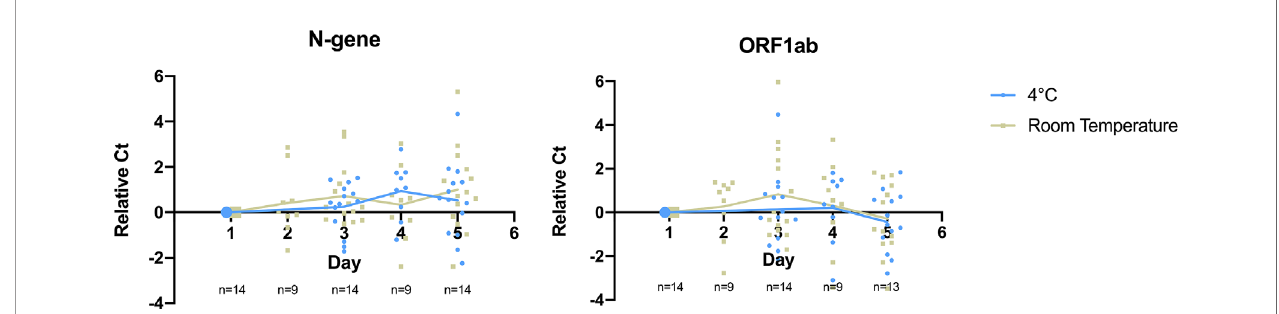
FIGURE 3 | Detection of SARS-CoV-2 target genes N-gene and ORF1ab remained stable for 5 days at cold and room temperature storage conditions. Relative Ct on the y-axis plots the difference between Ct value obtained at a given day and Day 1 for the monitored sample. Data points in blue refer to samples stored inside a refrigerator (2-8°C), while grey refers to samples stored at room temperature. Straight lines display the average relative Ct obtained across storage days.